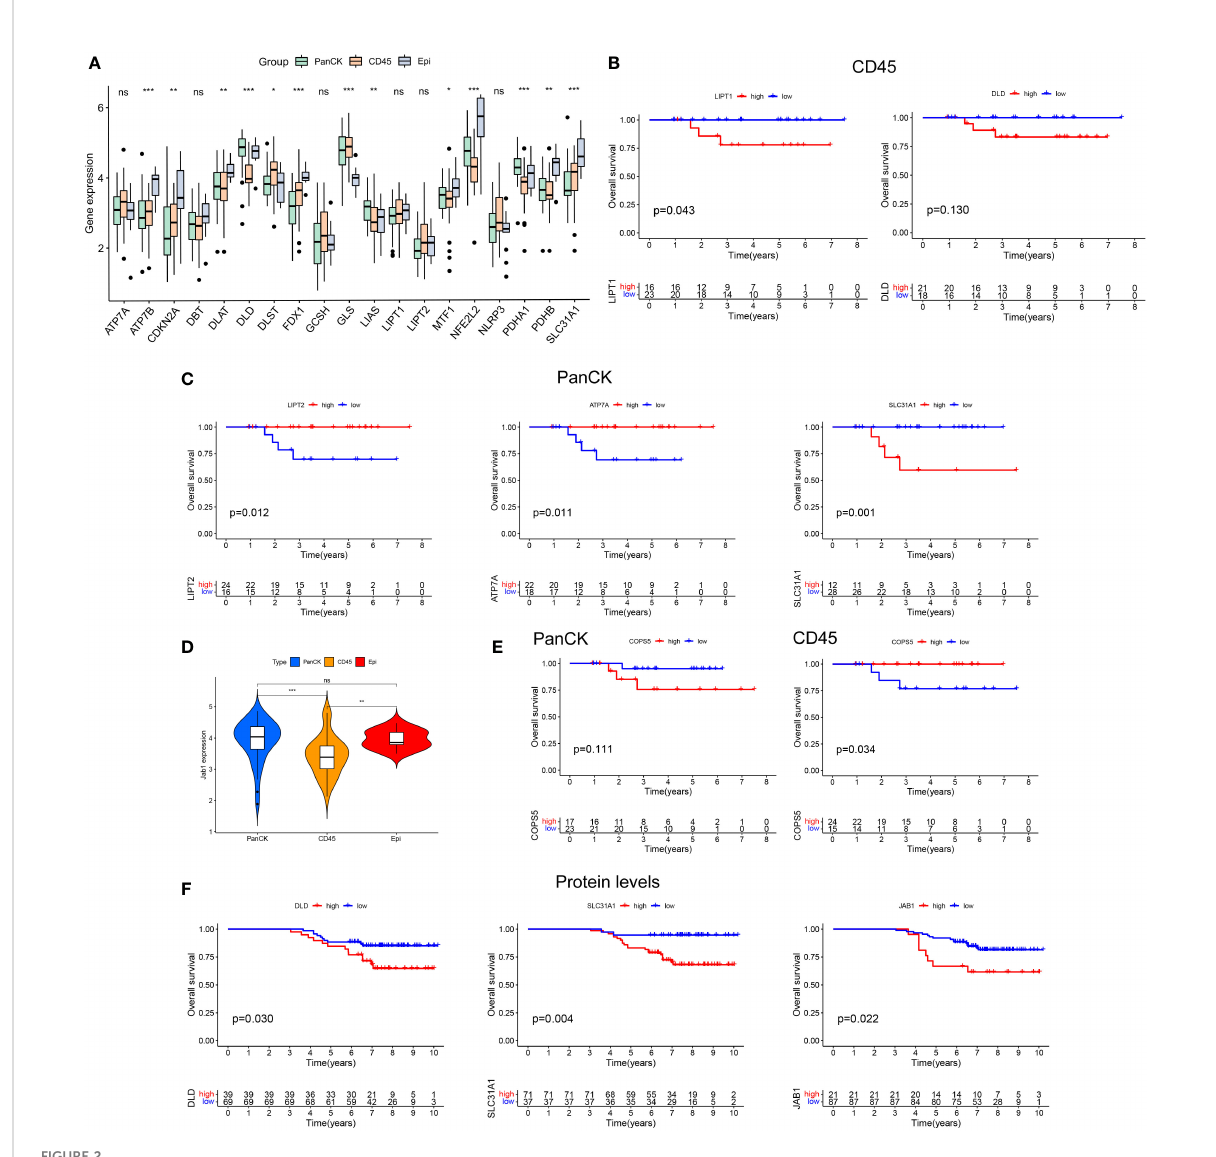
FIGURE 2 Heterogeneity of cuproptosis related genes and Jab1 in different regions of NPC tumor microenviroment. (A) Differential expression of cuproptosis related genes in three regions (tumor cell-enriched region, immune cell-enriched region, and normal epithelial region). (B) Cuproptosis related genes affect the survival of NPC patients in immune cell-enriched region. (C) Cuproptosis related genes affect the survival of NPC patients in tumor cell-enriched region. (D) Differential expression of Jab1 in three regions (tumor cell-enriched region, immune cell- enriched region, and normal epithelial region). (E) Jab1 affects the survival of NPC patients in tumor cell-enriched region and immune cell- enriched region. (F) Higher protein expression levels of cuproptosis related genes and Jab1 affect the survival of NPC patients. *p<0.05, **p<0.01, ***p<0.001, ns, not signi fi